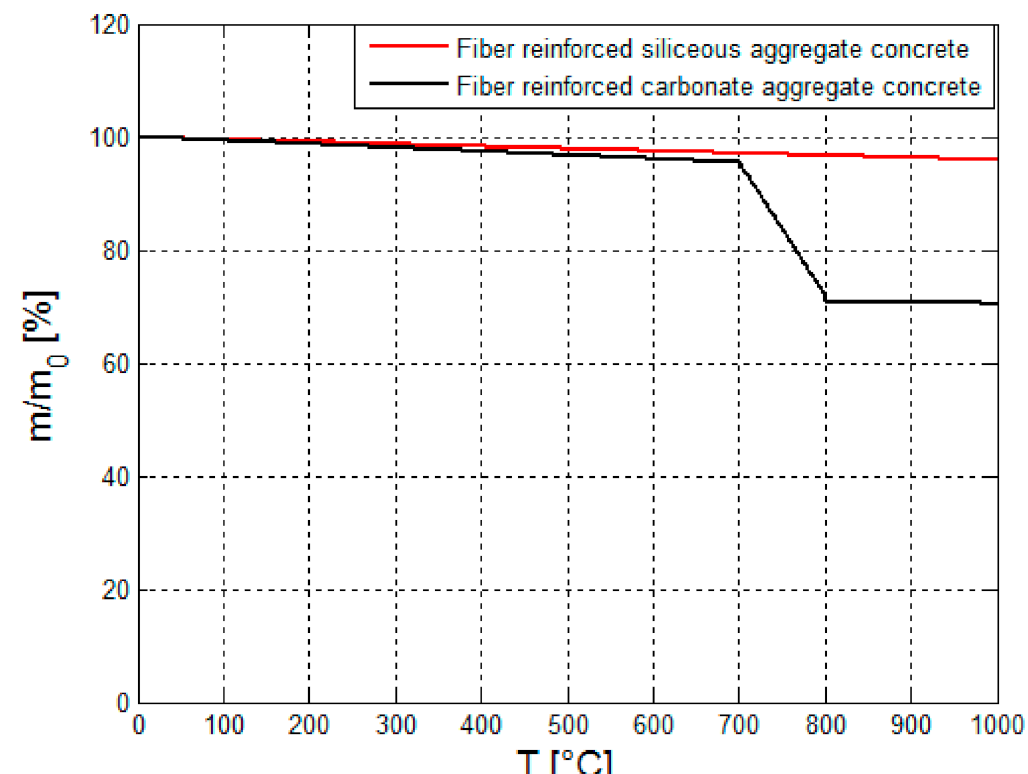
Figure 6. Mass loss curves of different kinds of concrete as a function of temperature